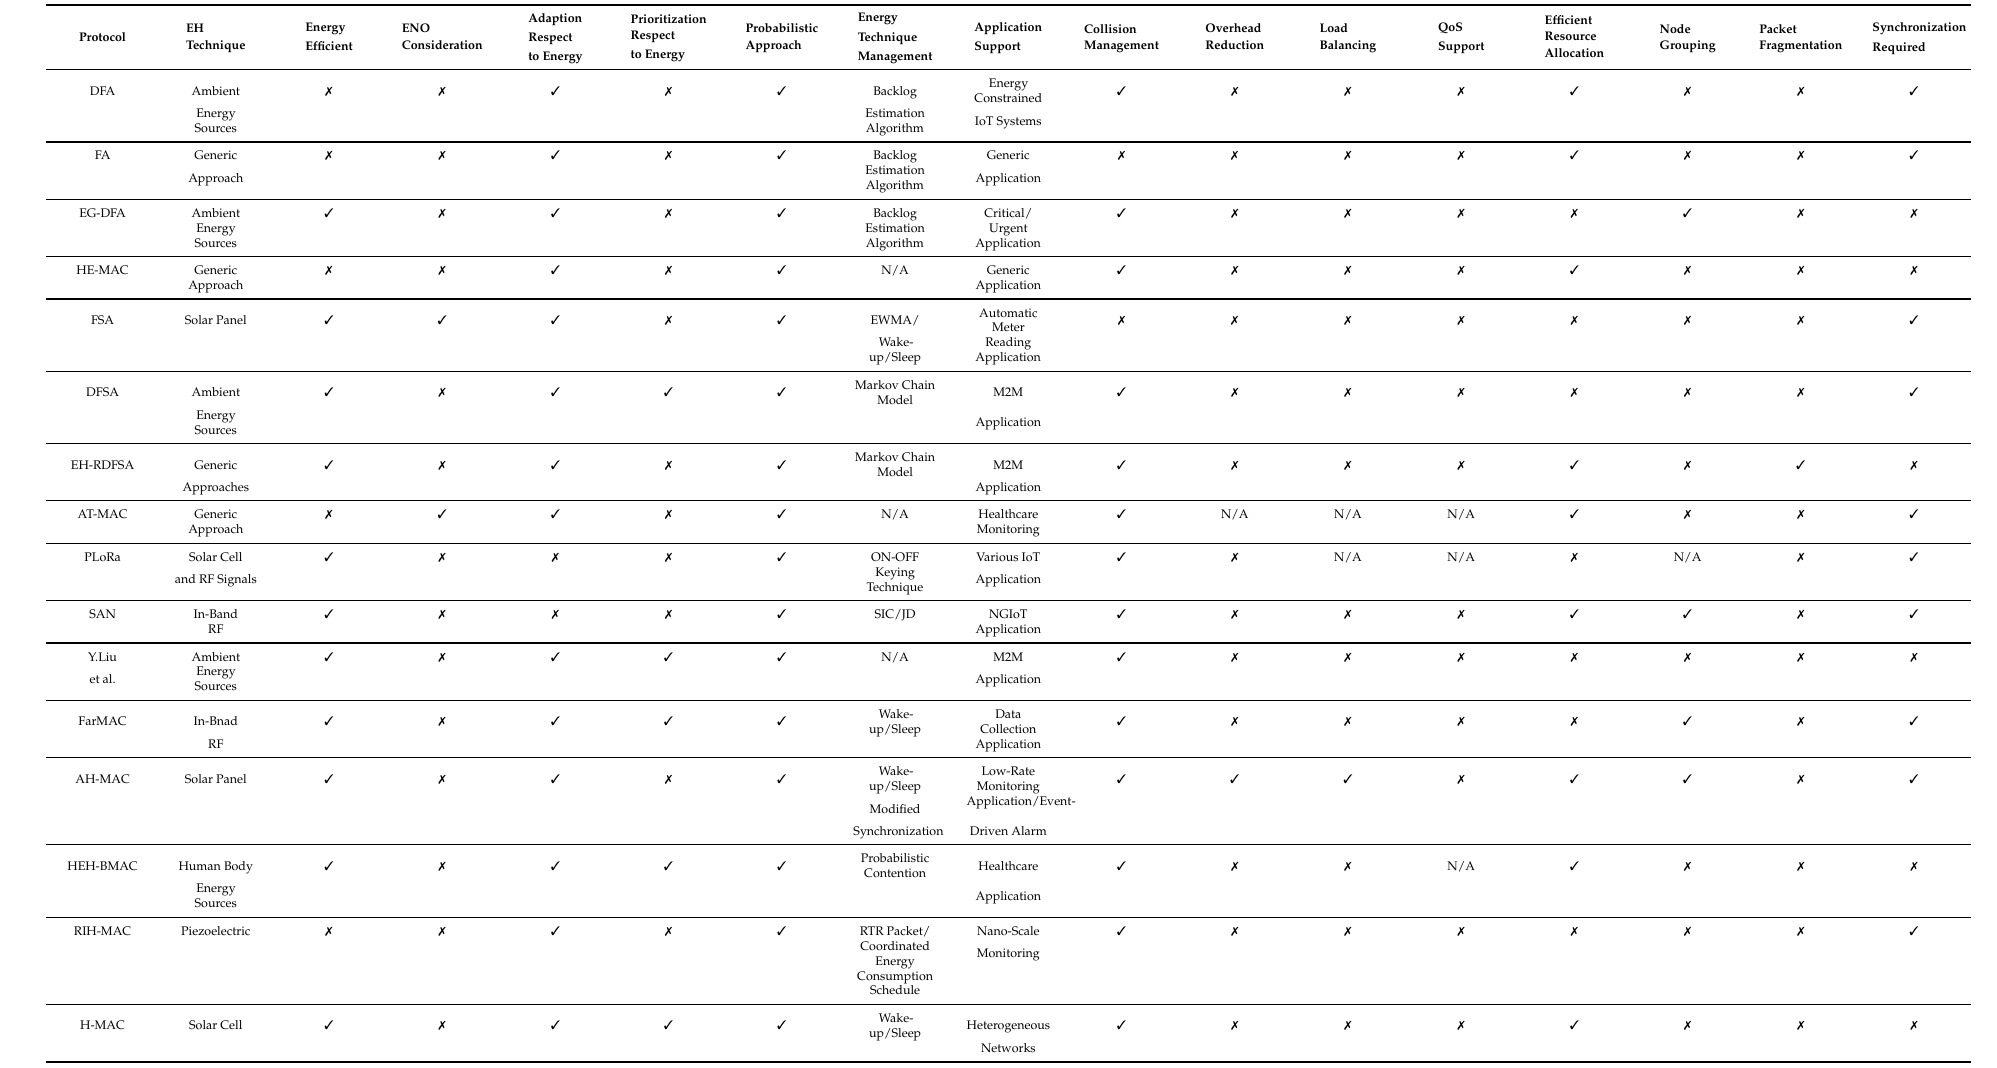
Table 9. Comparison of hybrid access energy harvesting MAC